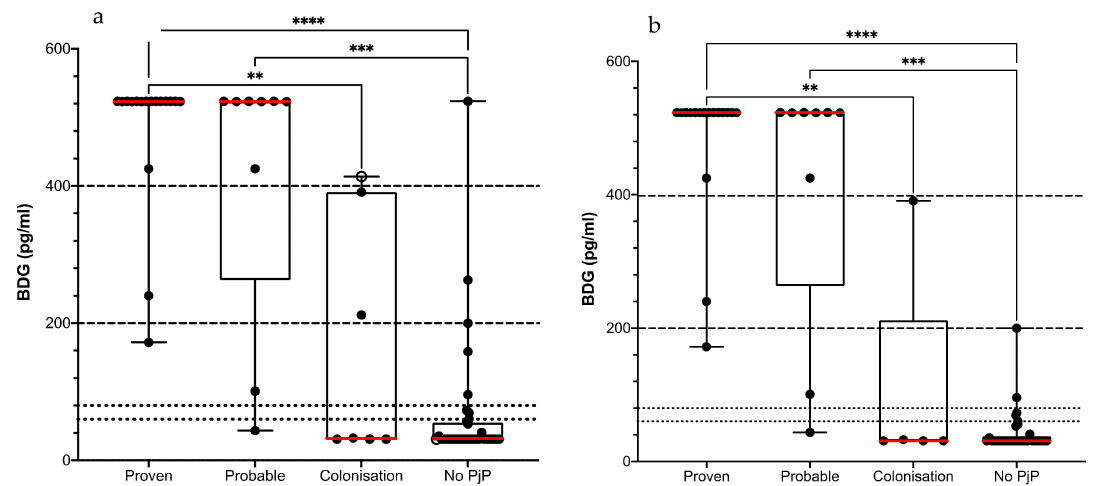
Figure 2. BDG value in 69 episodes from 67 HIV-positive patients suspected of PjP according to the final diagnosis retained. BDG values ( a ) with and ( b ) without evident cases of BDG false positive results. Comparison of the four groups was done using Kruskal-Wallis tests followed by Dunn’s pair-wise comparisons; p -adjusted values are indicated. Red line: median BDG value. ** p < 0.01, *** p < 0.001, **** p <